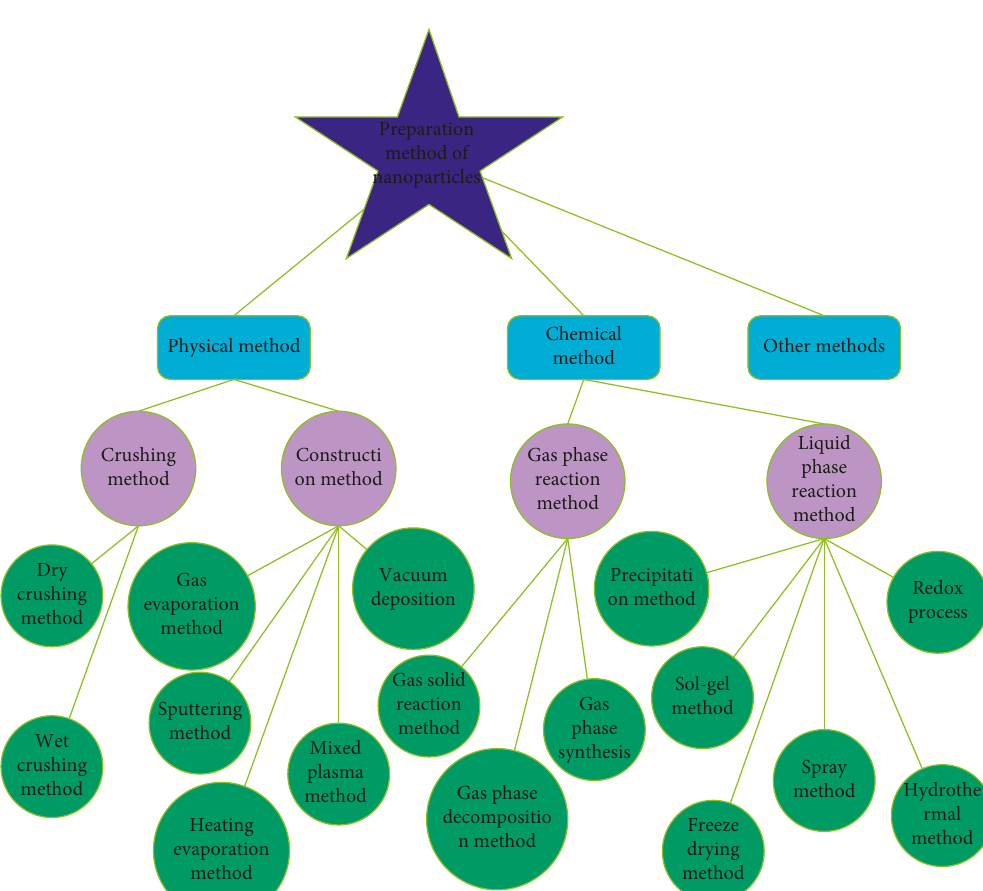
Figure 2: Nanoparticle preparation method.